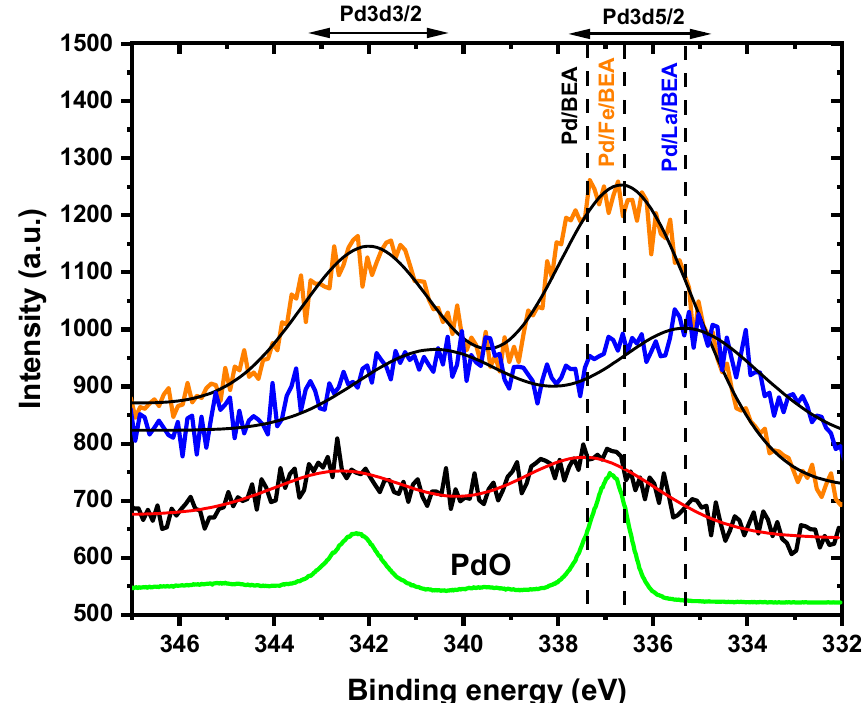
Figure 2. XPS measurements over Pd 3d3 / 2 and Pd 3d5 / 2. Pd / BEA in black, Pd / Fe / BEA in orange and Pd / La / BEA in blue. Dashed lines mark peak centers for Pd 3d5 / 2.